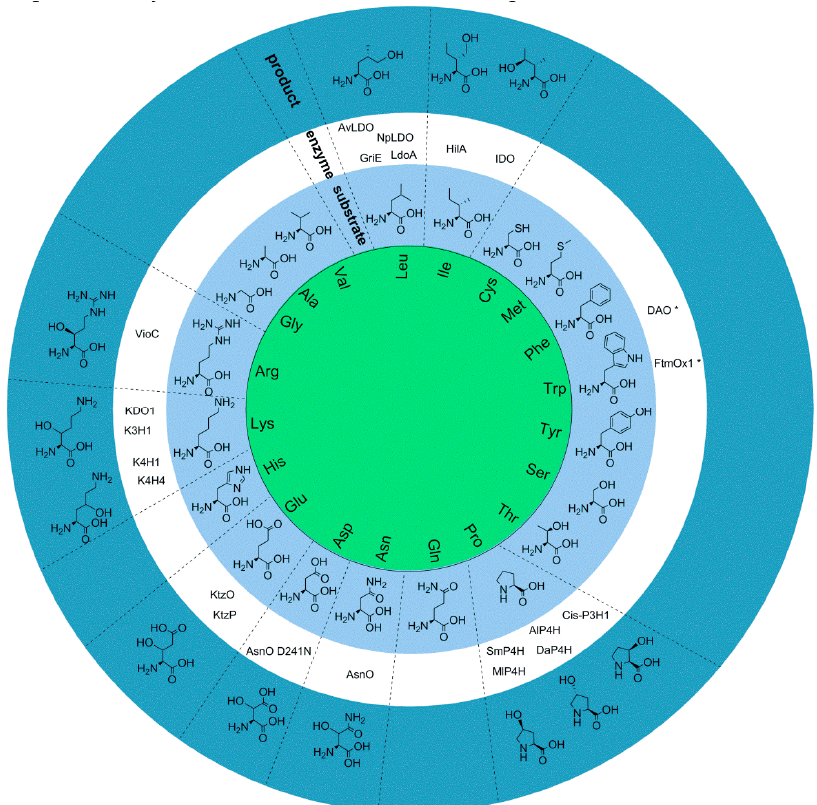
Figure 3. Overview of selected amino acid hydroxylations by 2-oxoglutarate-dependent enzymes. The enzymes typically accept free-standing amino acids as a substrate. In cases where the substrate is part of a more complex molecule, the enzyme name is marked with an asterisk.